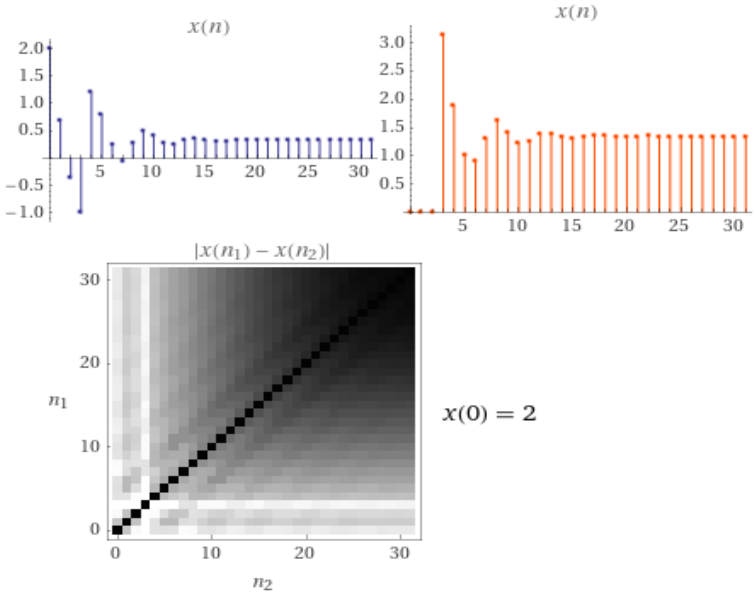
Figure 3. The plot of λ=x(n+1), where the points are the iteration of fixed